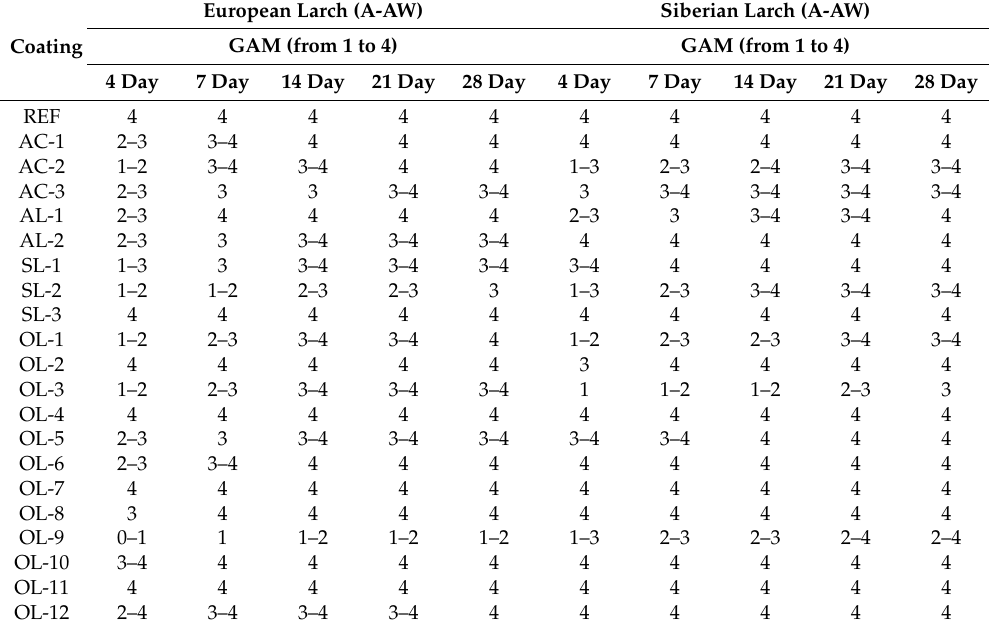
Table 5. Growth activity of moulds (GAM) on surfaces of larch samples treated with commercial coatings after artificial weathering lasted 2016 h